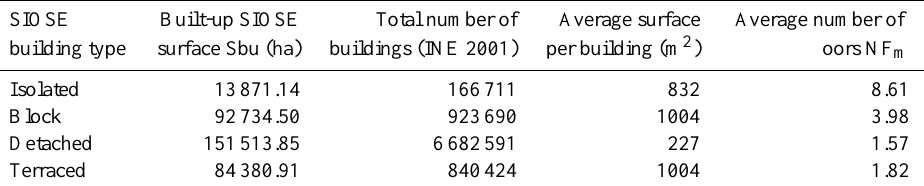
Table 5. Summary of results per building type.